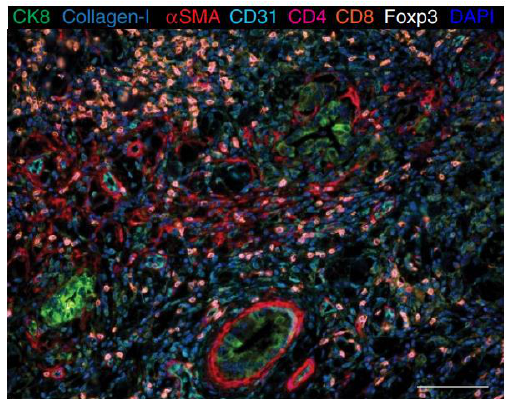
Figure 4. Opal™ shows multiplex staining in human pancreatic ductal adenocarcinoma (PDAC) tissue sections. CK8 (green), Collagen-I (extracellular teal blue), aSMA (cytoplasmic, red), CD31 (membrane, cyan), CD4 (membrane, pseudocolored magenta), CD8 (membrane, Cy5, orange), Foxp3 (nuclear, white), autofluorescence (black), and the DAPI nuclear marker (blue). Scale bar 100 µM. (Reprinted with permission from [46] , Copyright 2017 Springer Nature under a Creative Com- mons Attribution 4.0 International